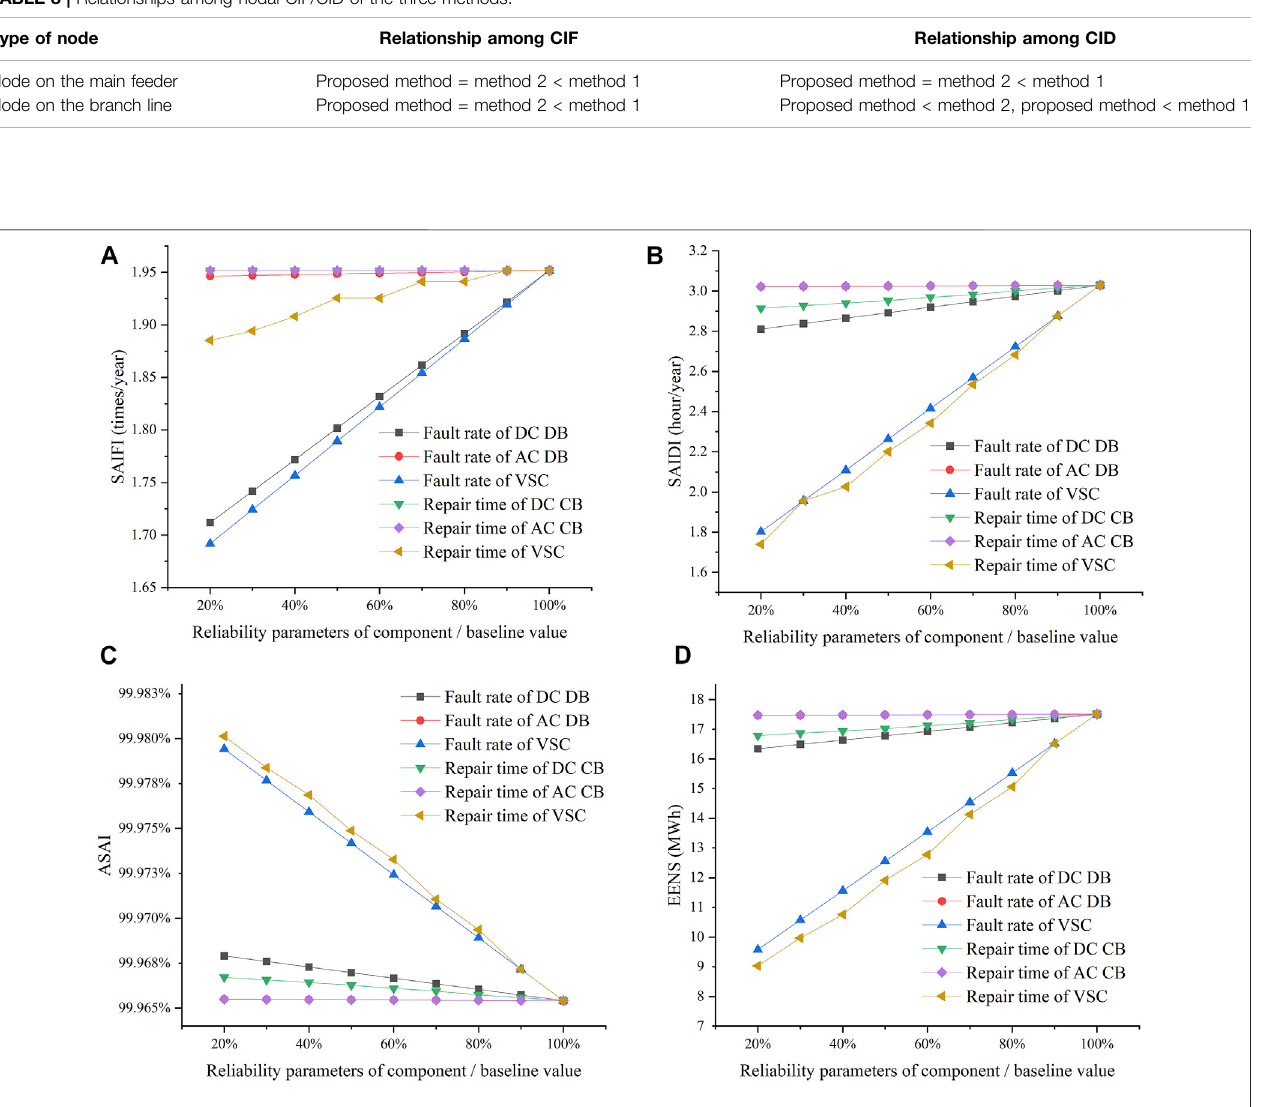
FIGURE 4 | Impact of the reliability parameters of components on system reliability indicators. (A) Impact of the reliability parameters of components on SAIFI. (B) Impact of the reliability parameters of components on SAIDI. (C) Impact of the reliability parameters of components on ASAI. (D) Impact of the reliability parameters of components on